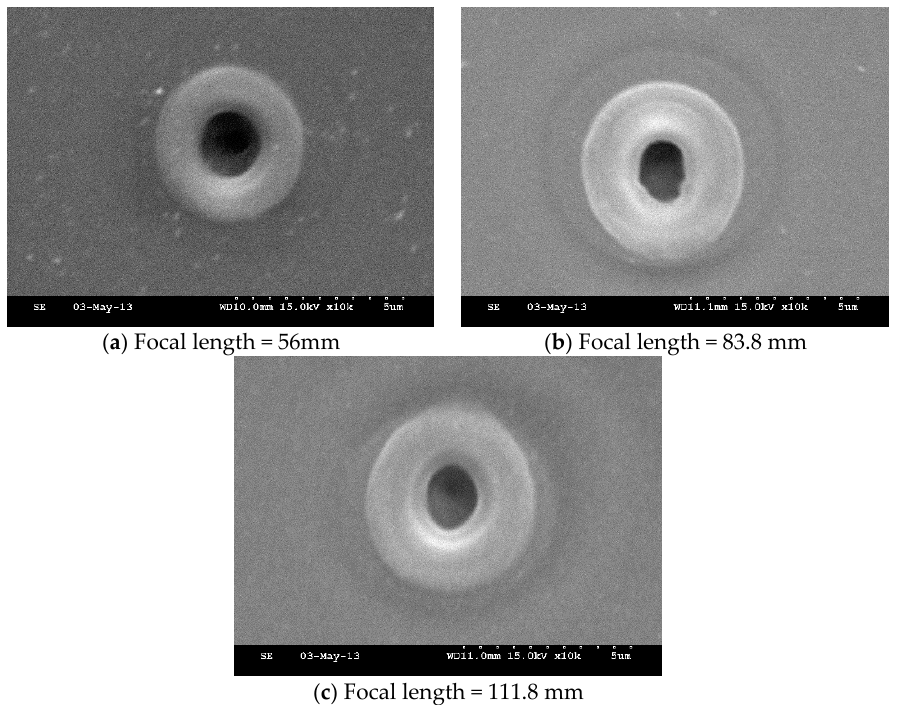
Figure 16. SEM picture of machined holes with different focal length (scale bar = 5 μ m).